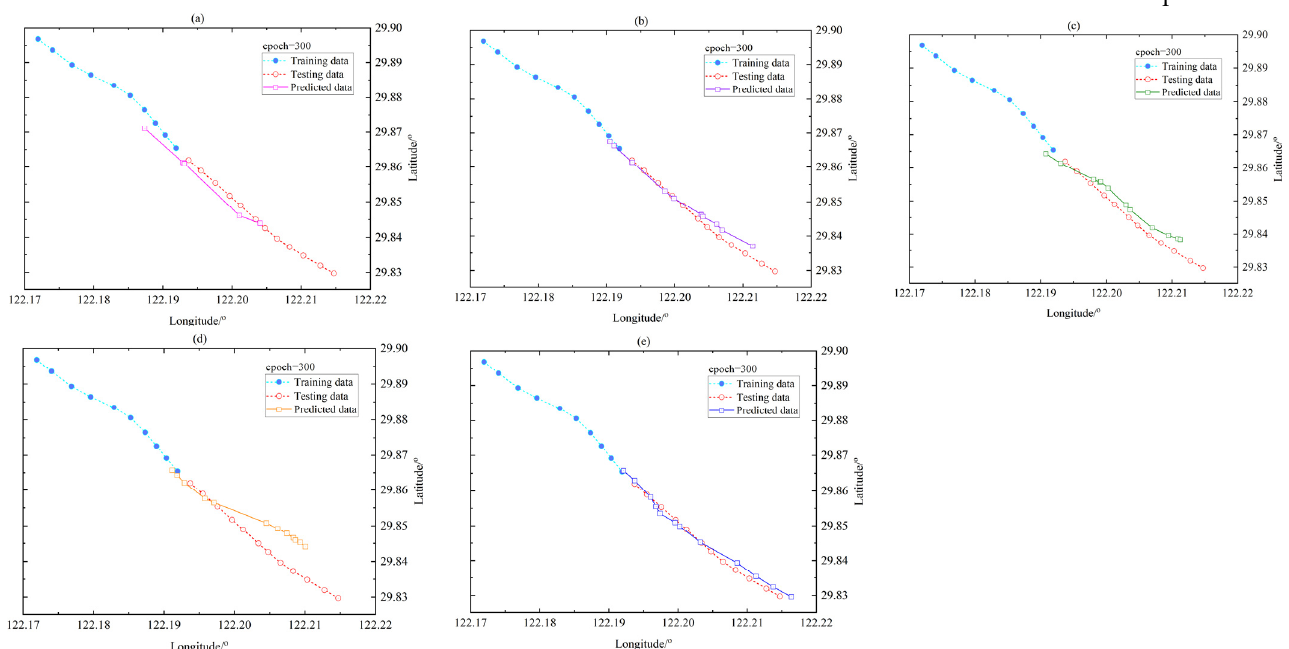
Figure 12. The comparison of the performance after learning 300 epochs of di ff erent methods: ( a ) LSTM ( b ) LSTM-a tt n ( c ) Bi-LSTM ( d ) SVR ( e ) TRFM-LS.